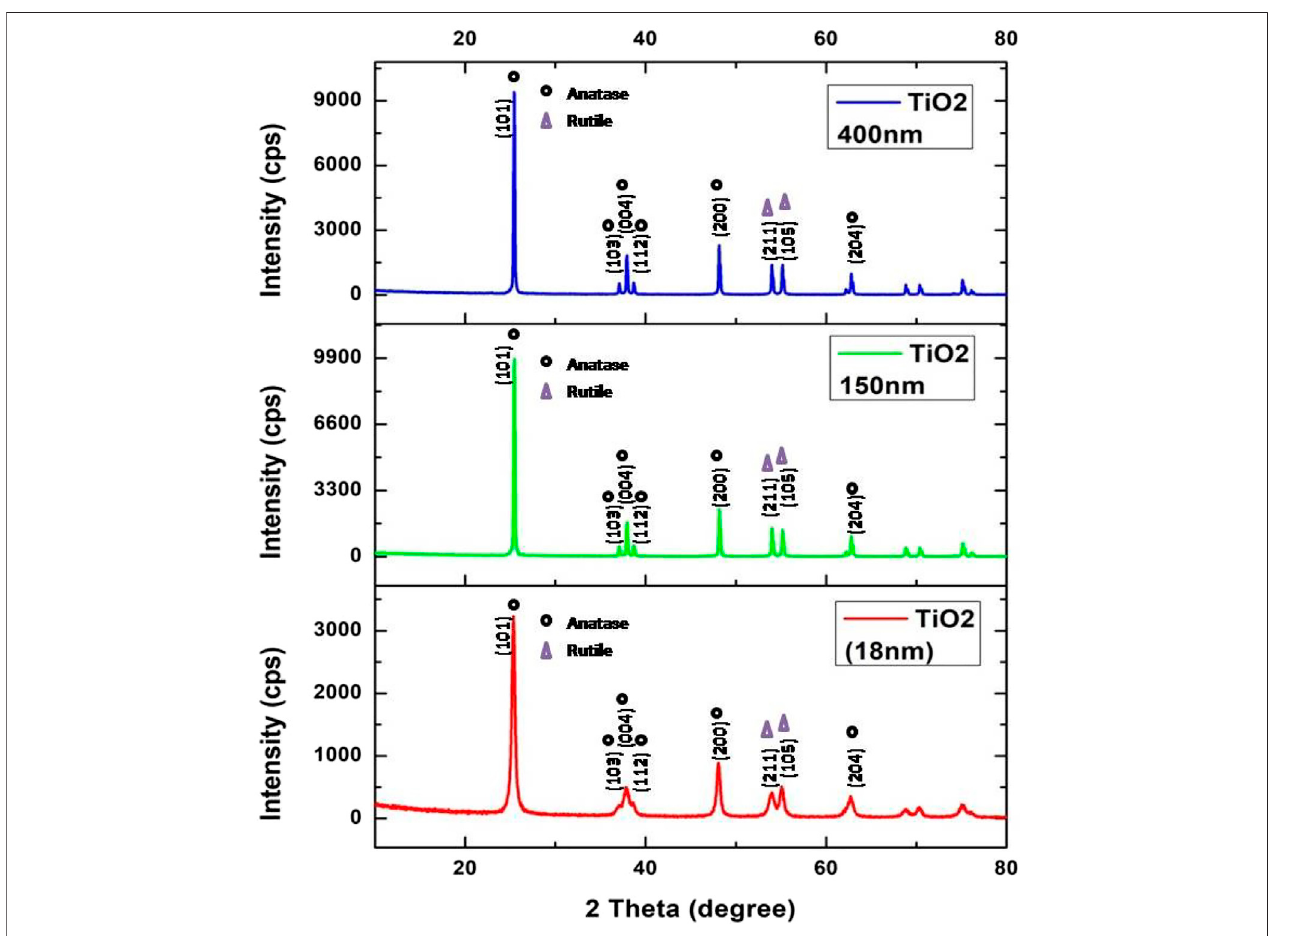
FIGURE 2 | XRD analysis of as-received TiO 2